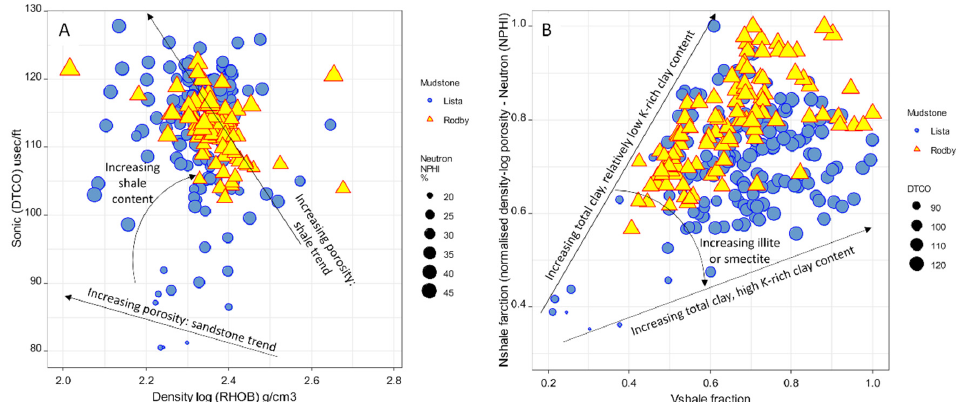
Figure 14. Comparison of raw and interpreted log properties for the Palaeocene Lista Shale (16 / 21-13 and 16 / 21-20; Figures 6 and 7) and the Lower Cretaceous Rodby Shale (14 / 26-1, 14 / 26a-7A and 14 / 26a-8; Figures 3–5). Diagrams prepared using R-studio-ggplot2 software [15] . ( A ) Density log (RHOB)